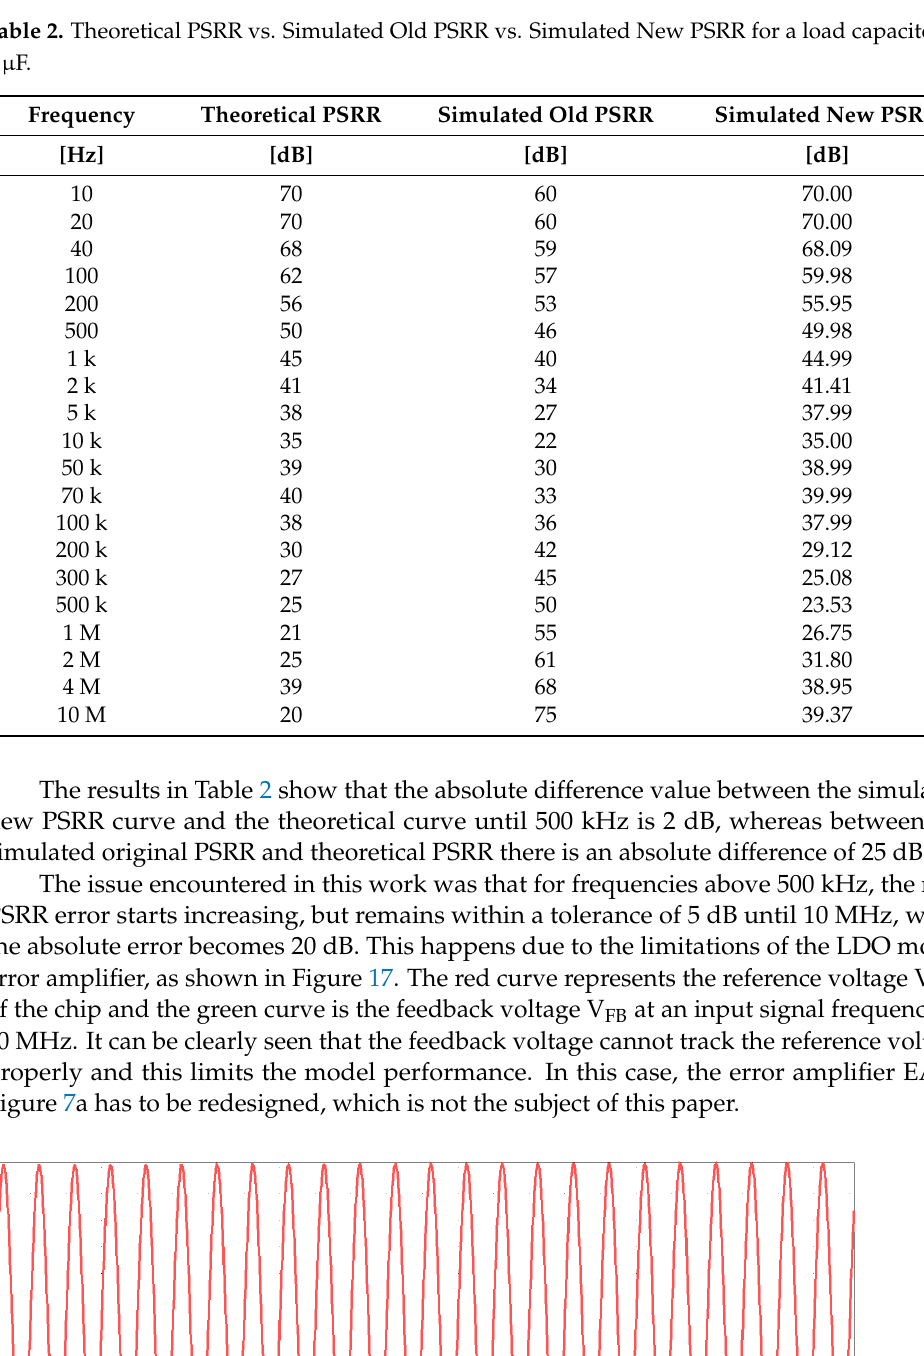
Table 3. Original PSRR error and New PSRR error vs. Frequency.